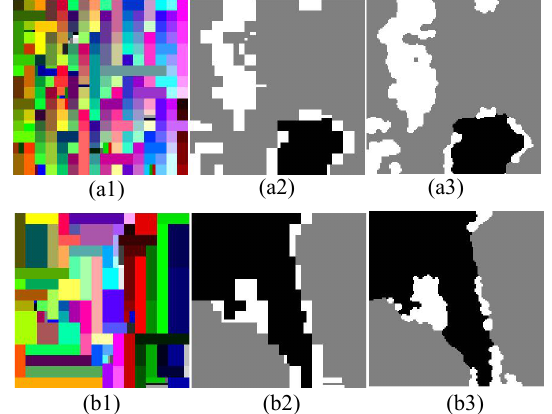
Figure 5. Segmentation results: (a1)-(b1) regular tessellation of segmentation, (a2)-(b2) segmentation results, and (a3)-(b3) refined segmentation.